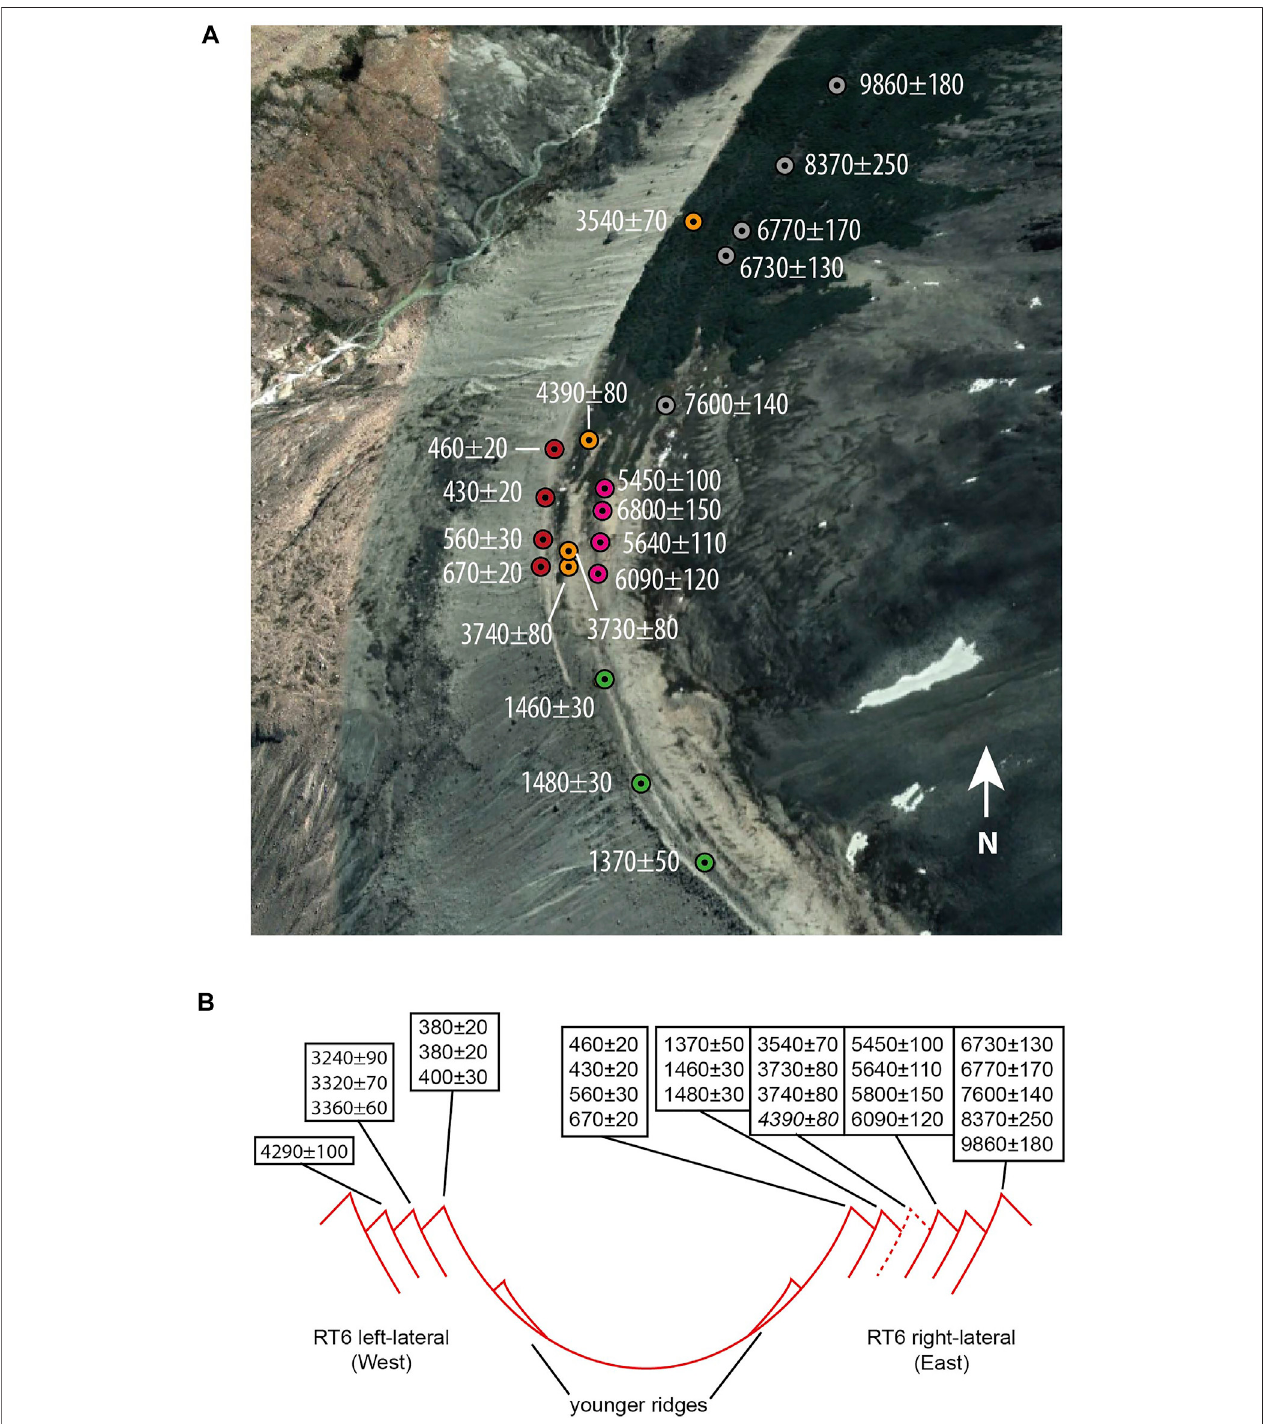
FIGURE 4 | Glacier chronology of Río Tranquilo glacier. (A) 10 Be ages obtained from the right lateral moraines (oblique perspective) on Google Earth image. (B) Schematiccrosssectionofthevalley.Noticethatthe ∼ 3,700 yearsridgewasdestroyedbythe ∼ 1,440 yearsadvanceintheupperrightsideofthevalley(asrepresented by the dotted line) (Sagredo et al., 2017).